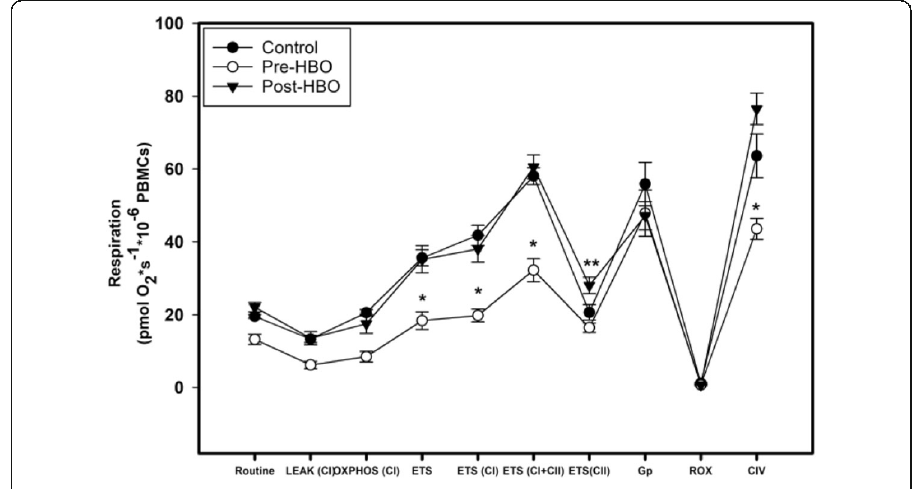
Fig. 3 Mitochondrial respiration in PBMCs. Cellular mitochondrial respiration obtained in permeabilized